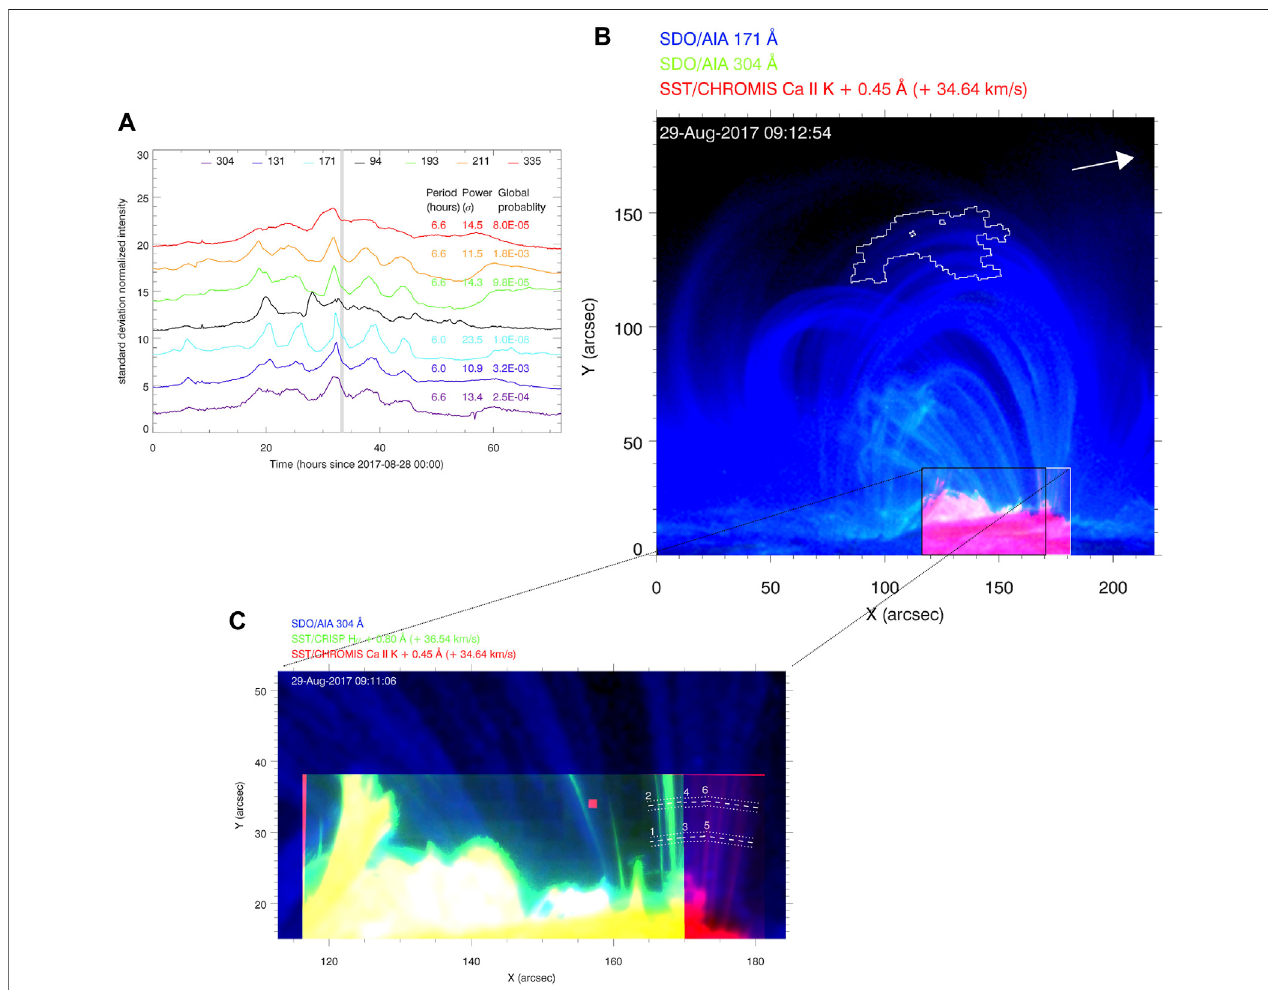
FIGURE 8 | Detection of long-period intensity pulsations and coronal rain in the same loop bundle. (A) EUV light curves in seven spectral bands of the SDO /AIA. There is signi fi cant Fourier power in most spectral bands. These light curves are averaged over the white contour near the loop apex of the right panel. (B) RGB image combiningtwospectralbandsof SDO /AIAandCaIIKobservationsfromtheSST/CHROMIS. (C) Zoomonthecoronalrainobservedwiththe SST instruments.Allthese fi gures are adapted from Froment et al. (2020) (Figures 2, 4, 7, reproduced with permission © ESO. ).